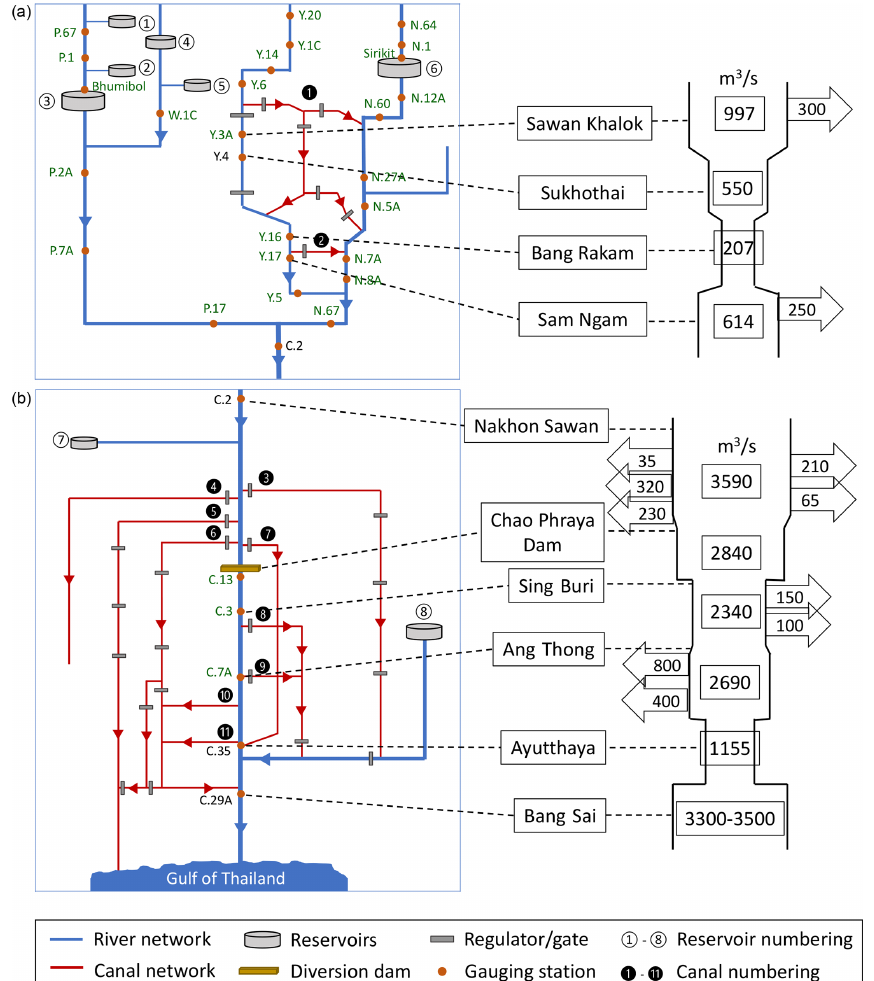
Figure 4. The left-hand side shows the schematic diagram of different existing water infrastructures in the (a) upper CPRB and (b) lower CPRB. The right-hand side shows the observed river channel carrying capacity shown inside the river schematic and the observed canal carrying capacity shown in the left and right arrows for various locations within the CPRB. Please refer to Table 1 for the canal numbering and Table S2 in the Supplement for the reservoir numbering. The green coloured gauging stations represent validation